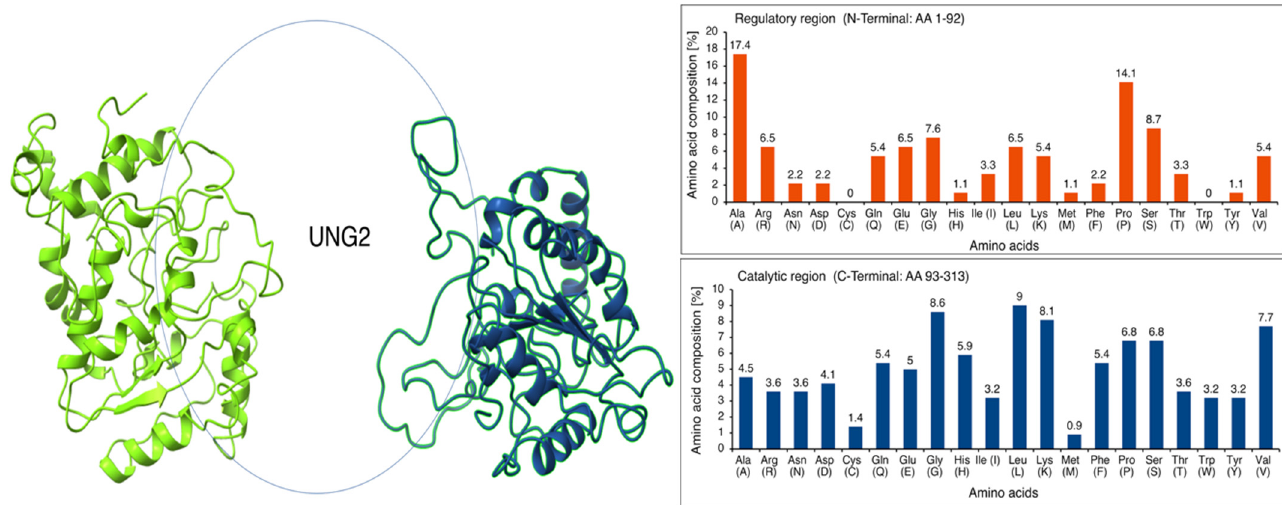
Figure 2. ( Left ): The intrinsically disordered proteins (IDP) regions in the I-TASSER- and Modeler-based predicted models is circled. Left-hand side: I-TASSER output; right-hand side: Modeler output. A similar N-terminal IDP was obtained with AlphaFold (Figure 1). ( Right ): AA composition was calculated for AA residue enrichment in promoting ordered or disordered regions in UNG2. The AA composition of UNG2 analysis clearly shows the abundance of disorder-promoting AAs Ala, Pro, Ser, and Gly within the N-terminal regulatory region, while the catalytic region is enriched by hydrophobic order-promoting AA residues, including Leu, Val, Ile, and Trp. Evidently, Cys and Trp are not available for a foldable secondary structure formation as linker residues form in the N-terminus of UNG2. The plot shows biases in AA composition at N-terminal residues and explains the importance of sulfur-containing AAs and tryptophan at hydrophobic cores for protein rigidity. The absence of AAs, such as Cys and Trp, has been recognized by evolutionary studies of protein plasticity and disordered protein regions in previous studies.